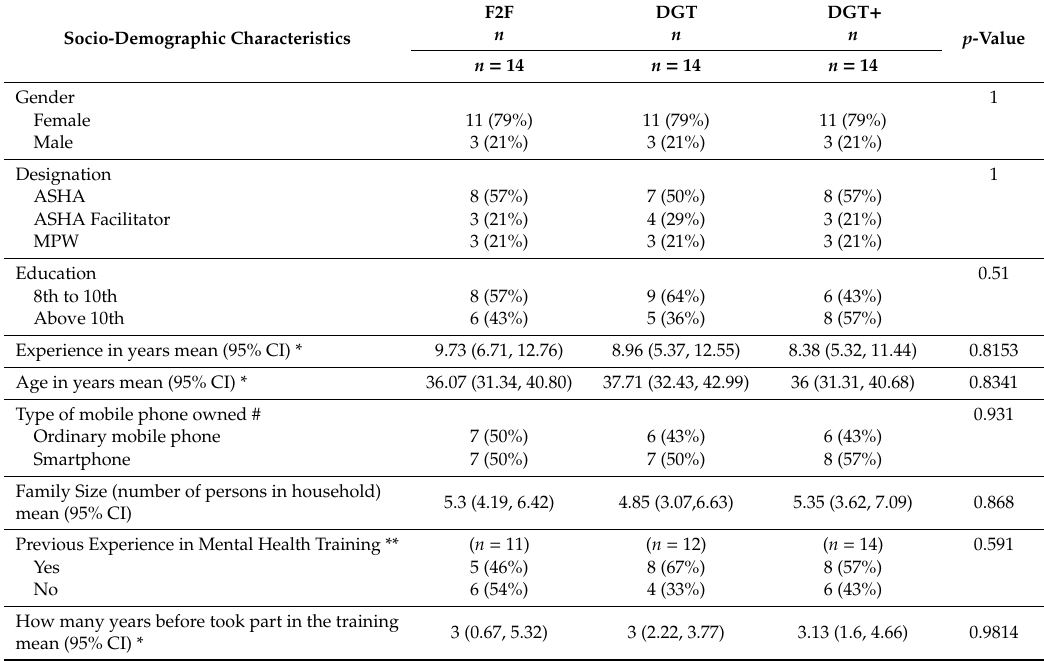
Table 1. Baseline socio-demographic characteristics of study participants.